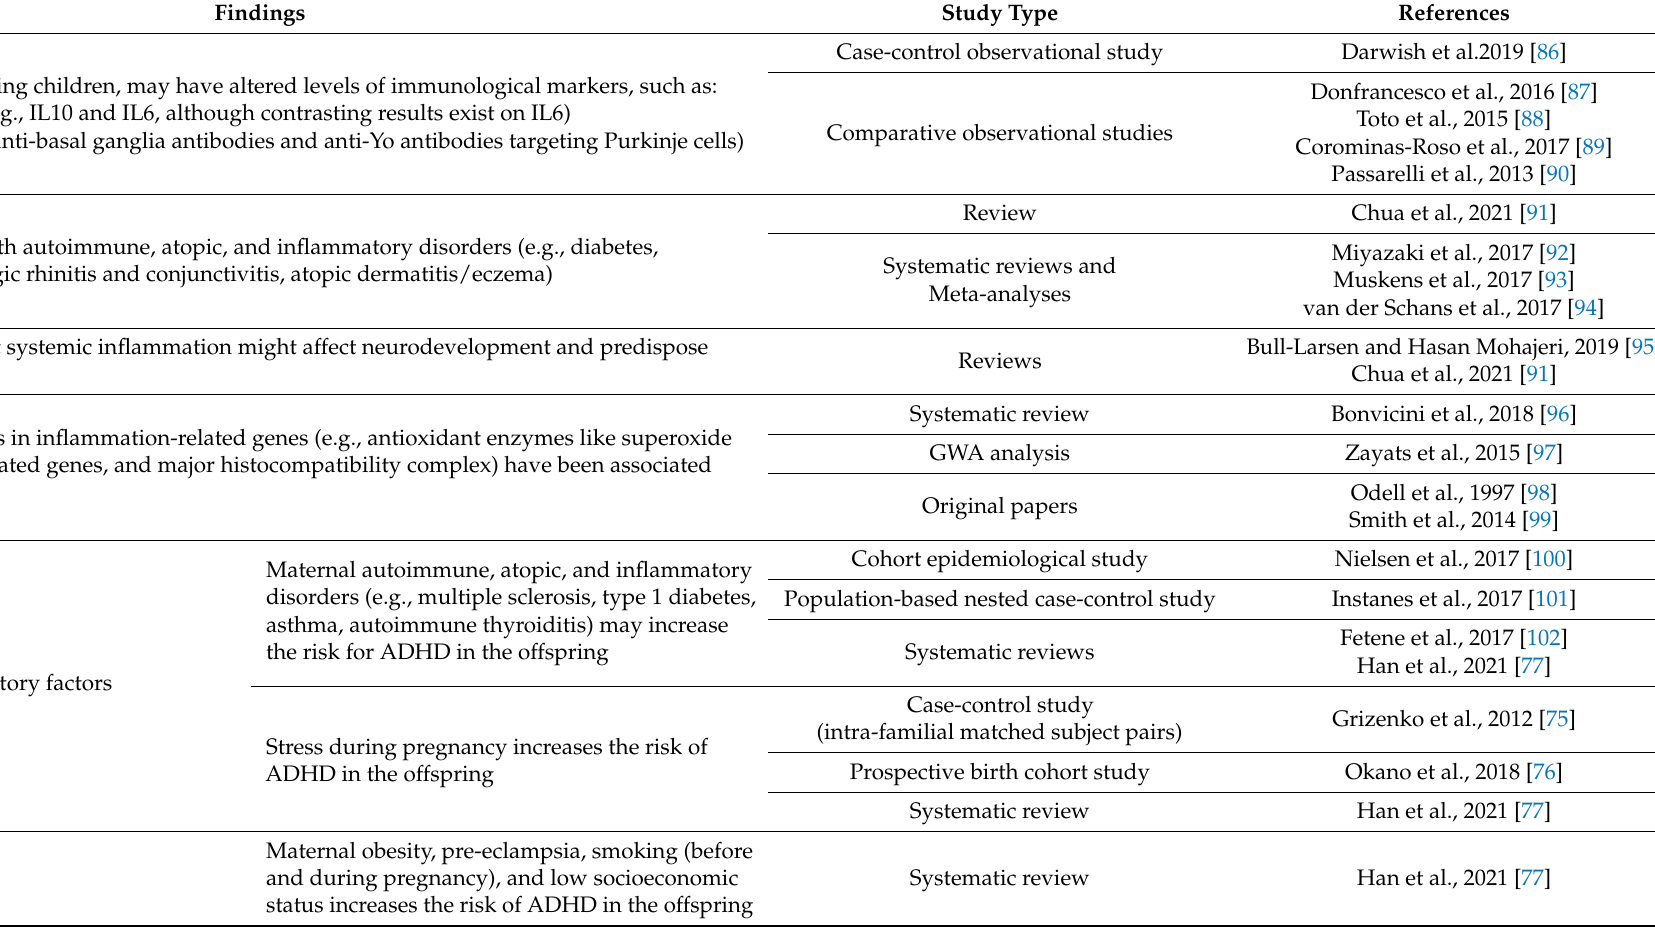
Table 1. Inflammation in attention-deficit/hyperactivity disorder (ADHD). Principal findings concerning inflammation in ADHD are recapitulated in the table. IL, interleukin; GWA, Genome-wide